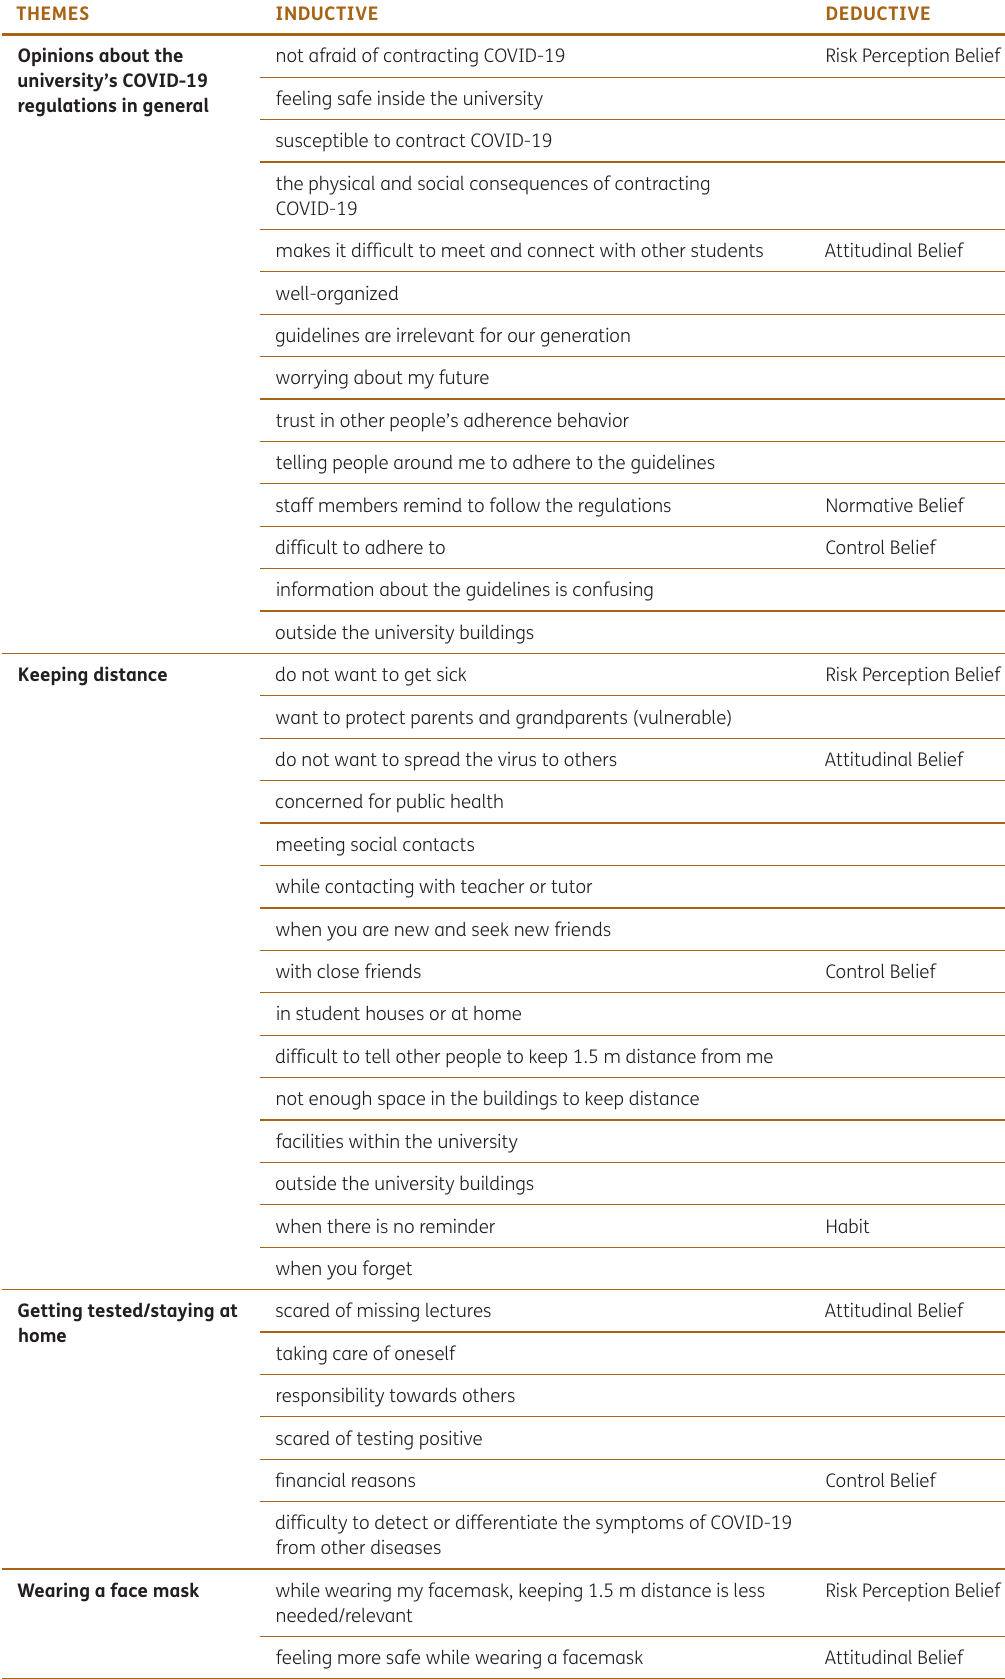
Table 1 Determinants and underlying beliefs of students’ adherence to the